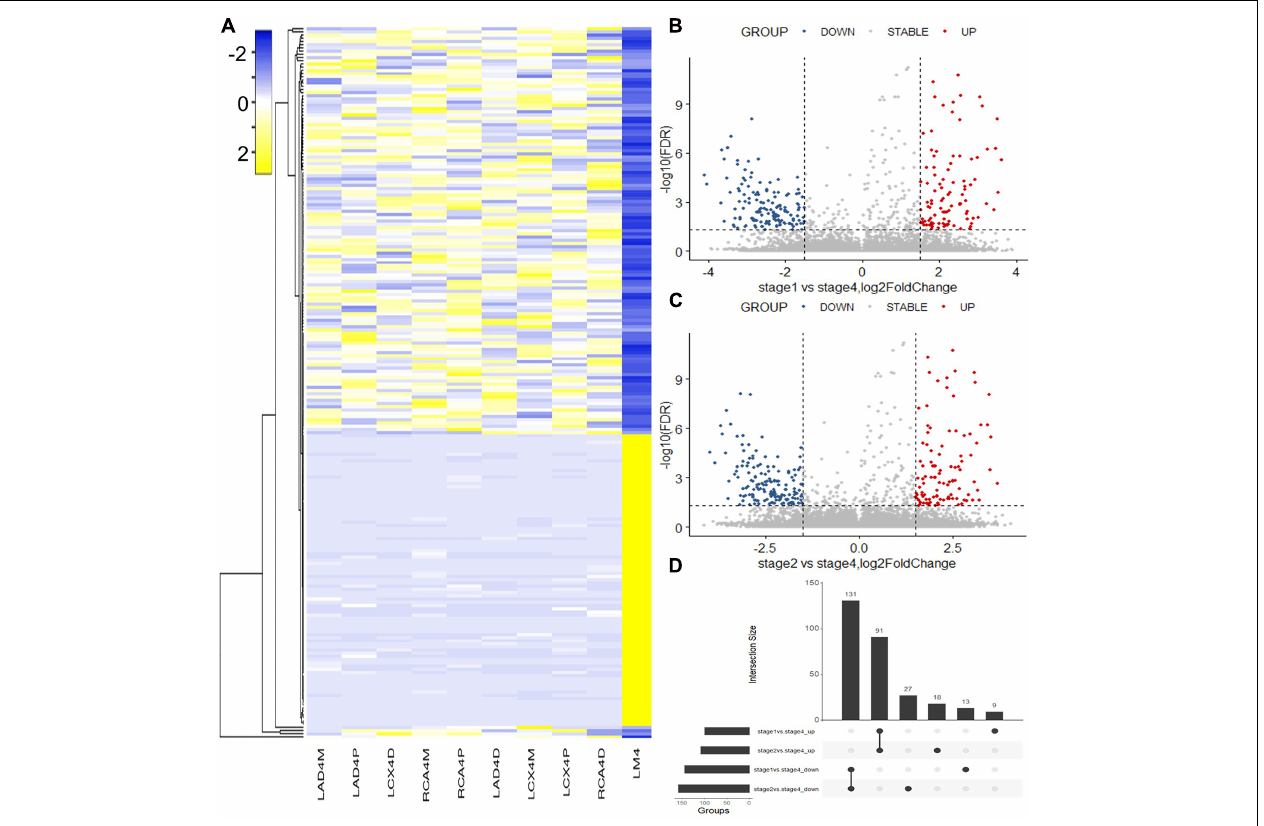
FIGURE 2 | Differentially expressed mRNAs identified with RNA sequencing. (A) Heatmap of the differentially expressed mRNAs between coronary artery segments. (B) Volcano map of differentially expressed mRNAs between stage 1 and stage 4. (C) Volcano map of differentially expressed mRNAs between stage 2 and stage 4. (D) The intersection of differentially expressed mRNAs in stages 1 and 2 vs. stage 4. Stage: 0, normal tunica intima; 1, fatty streak tunica intima; 2, fibrous plaques tunica intima; 3, atherosclerotic tunica intima; 4, secondary affection tunica intima. TABLE 2 | Summary of the comparisons of lncRNA and mRNA expression levels in different stages of atherosclerosis. Differential analysis Intersection Stage 1 vs. Stage 4 Stage 2 vs. Stage